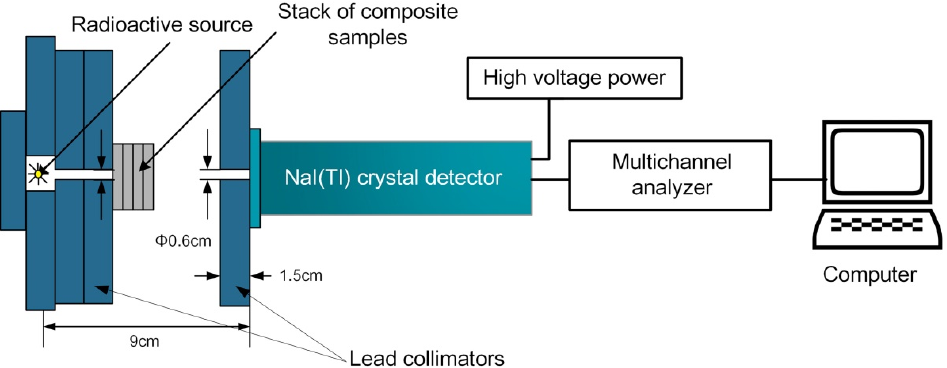
Figure 4. Investigation of photon-shielding properties. Reprinted from [95], with permission from Elsevier.